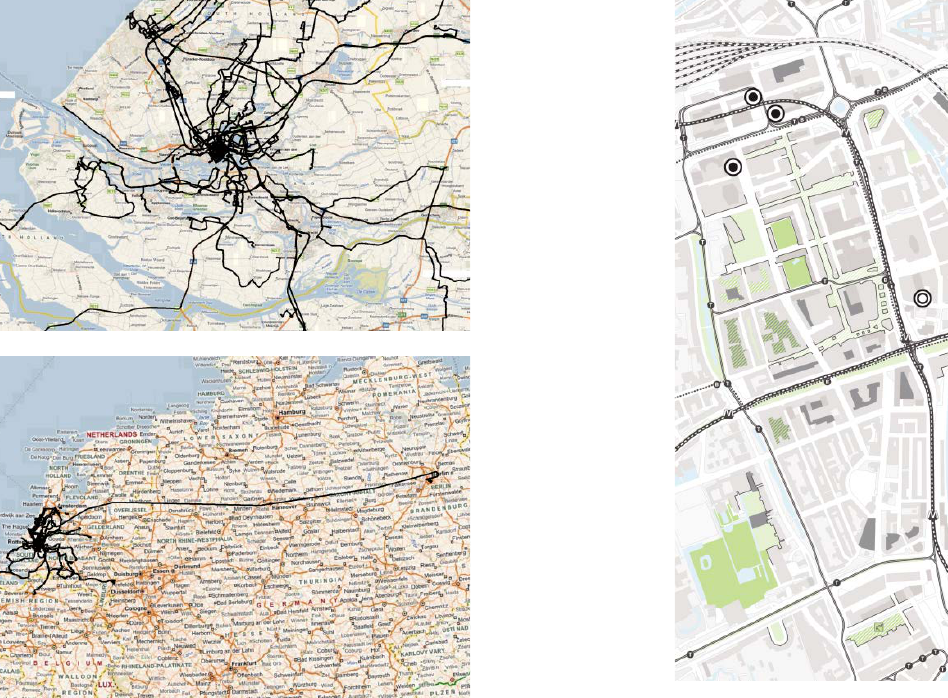
Figure 3. First tracking results of Tracking High-rise, Rotterdam, May 2011: (left, top) regional pattern, (left, bottom) (inter-) natio- nal pattern, (right) clusters of participating Highrise buildings (black